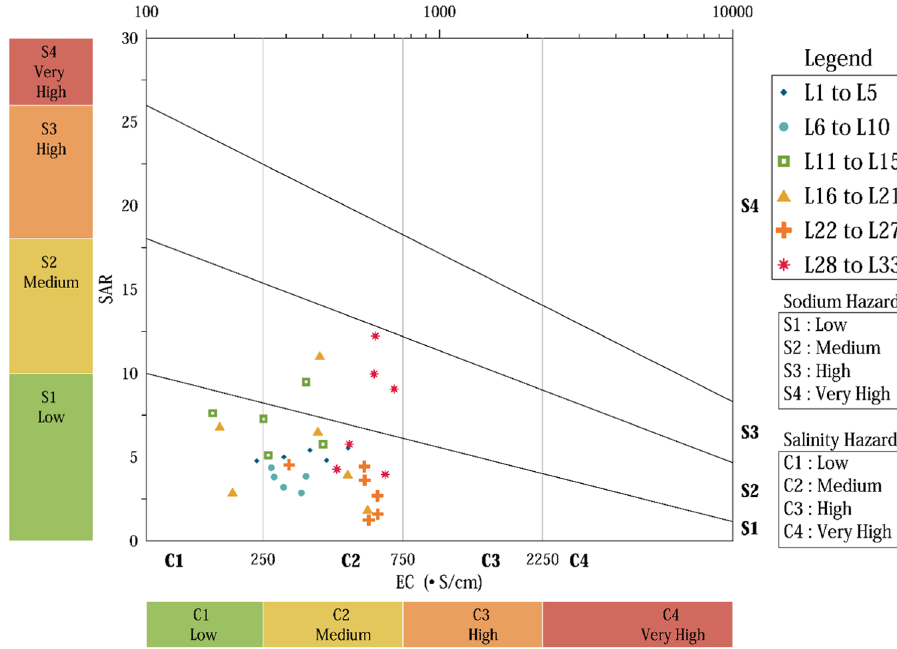
Fig. 5 USSL Diagram showing classification based on sodium hazard (SAR) and salinity hazard